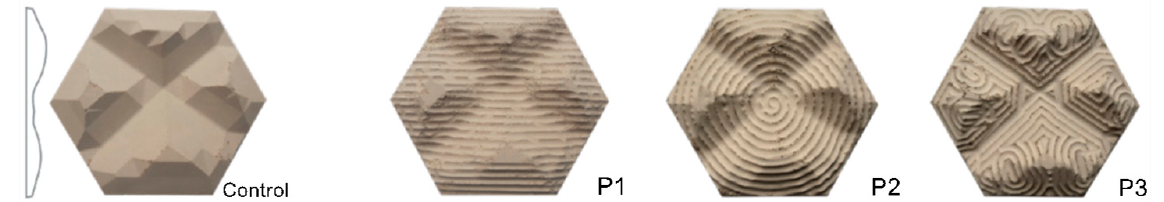
Figure 12. Iterations of patterns: P1—horizontal lines; P2—spiral lines; P3—curvy random lines.